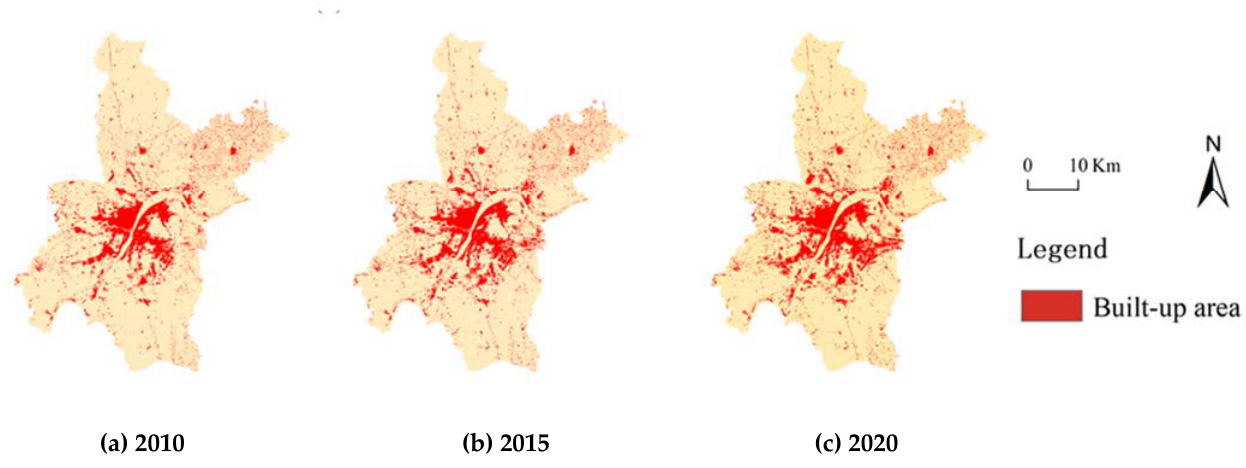
Figure 5. Built-up area in Wuhan city in ( a ) 2010, ( b ) 2015, and ( c ) 2020. We extracted and overlaid the active area of nighttime light and the built-up area from the land-use data to obtain the urban built-up areas in 2010, 2015, and 2020 (Figure 6). According to the statistics, the built-up areas were 503km 2 , 568.13km 2 , and 887.56km 2 , respectively. The expansion direction of the urban built-up area was mainly in the south and northeast. This result is basically consistent with the built-up area and urban expansion direction of the urban development area in the Wuhan Urban Master Planning (2010–2020) [39].